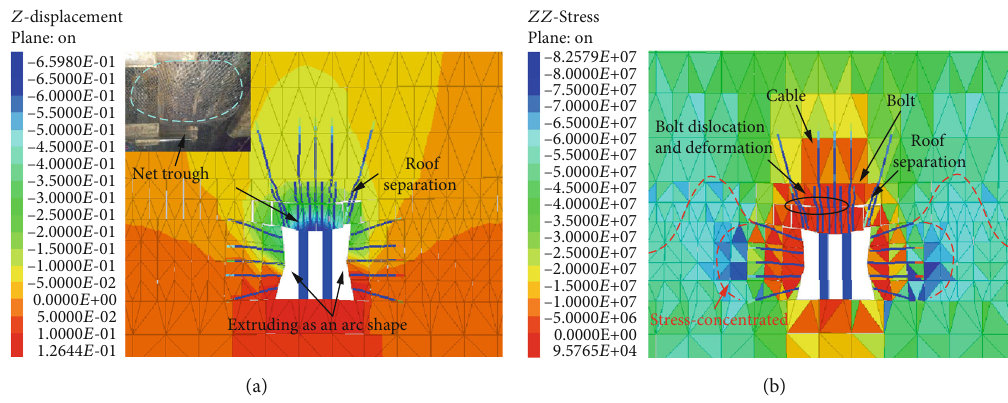
Figure 5: Numerical simulation results of the surrounding rock deformation at 20 m in front of the coalface: (a) cloud graph of vertical displacement; (b) cloud graph of vertical stress.